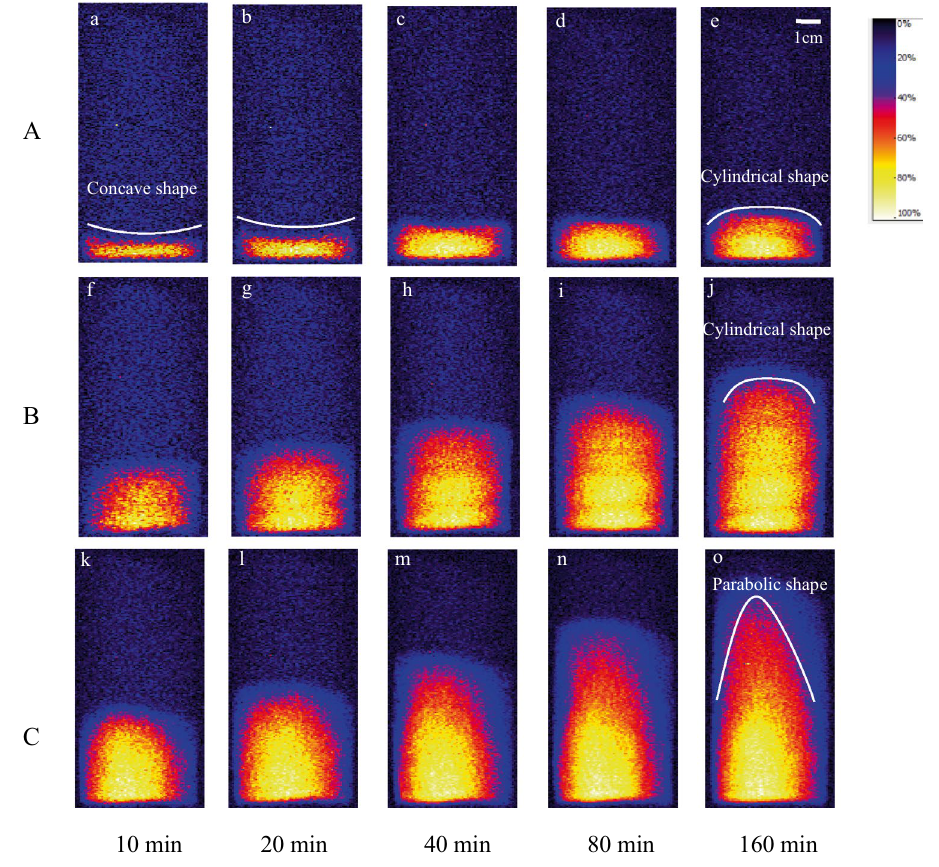
Figure 5. Liquid capillary rise characteristics with different porosities (50